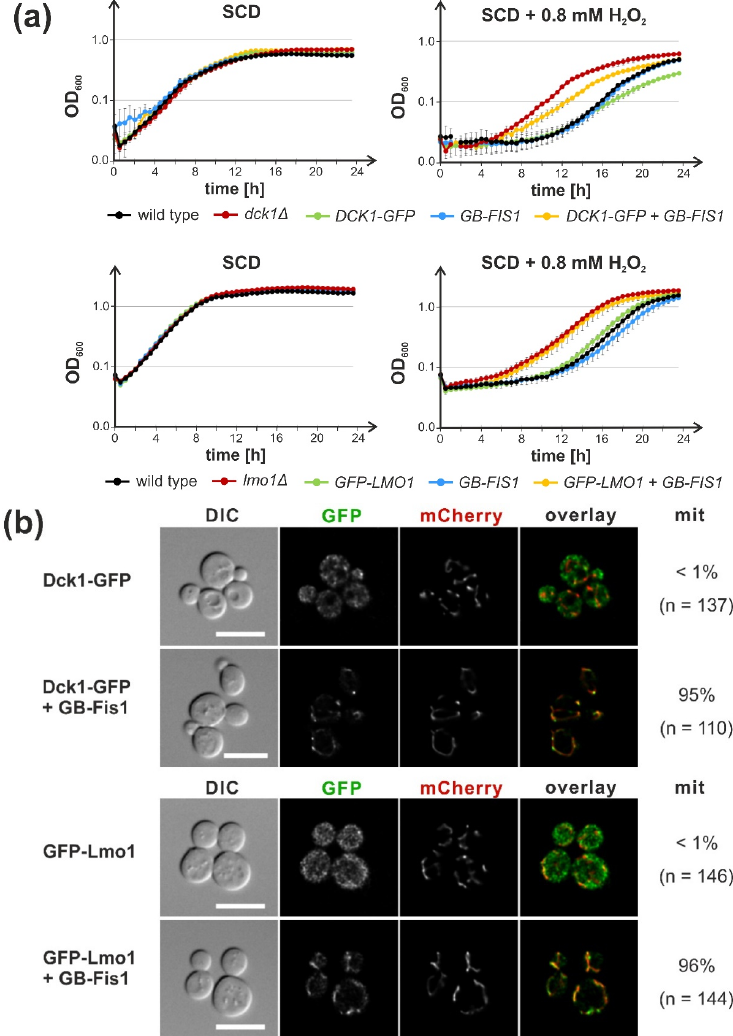
Figure 3. Trapping of GFP-tagged Dck1 and Lmo1 to mitochondria results in hyper-resistance towards oxidative stress. ( a ) Growth of strains producing Dck1-GFP ( upper panel) or GFP-Lmo1 ( lower panel) fusion proteins encoded at their native genomic loci in combination with a GFP binding nanobody attached to the mitochondrial surface ( GB-FIS1 TMD ) in the absence ( left ) or presence ( right ) of hydrogen peroxide. Error bars give the standard deviations from growth recorded in duplicate for two independent strains, each, with the exception of the wild-type strain, for whom only one was measured in duplicate. Strains employed in the upper panel were: wild-type = HLBO20-4B; dck1 ∆ = HD56-5A/dck1 ∆ H1 and HD56-5A/dck1 ∆ KL6; DCK1-GFP = HLBO22-2A and HLBO22-4D; GB-FIS1 = HLBO22-2D and HLBO22-9D; DCK1-GFP + GB-FIS1 = HLBO22-3B and HLBO22-5B; and in the lower panel: wild-type = HLBO20-4B; lmo1 ∆ = LBO81 and HOD464-7B; LMO1-GFP = HCLO01-3B and HLBO19-3A; GB-FIS1 = HCLO01-8B and HCLO01-27D; LMO1-GFP + GB-FIS1 = HCLO01-15C and HCLO01-23D. ( b ) Dck1-GFP and GFP-Lmo1 are efficiently recruited to the mitochondrial surface by a nanobody fused to the transmembrane domain of Fis1. Fluorescence microscopy images were taken for cells grown in synthetic medium with 2% glucose as explained in the legend of Figure 2. An Idp1-mCherry fusion encoded at the native IDP1 locus was used as a mitochondrial marker. Percentages of cells showing a colocalization of the tagged GEF subunits with mitochondria (mit) are given, calculated from the total number of cells inspected (n). Size bars correspond to 5 µ m. The strains employed were DCK1-GFP = HLBO21-2A and HLBO21-10A; DCK1-GFP + GB-FIS1 = HLBO21-3D and HLBO21-6A ; GFP-LMO1 = HLBO19-3B and HLBO19-5A ; GFP-LMO1 + GB-FIS1 = HLBO19-1B and